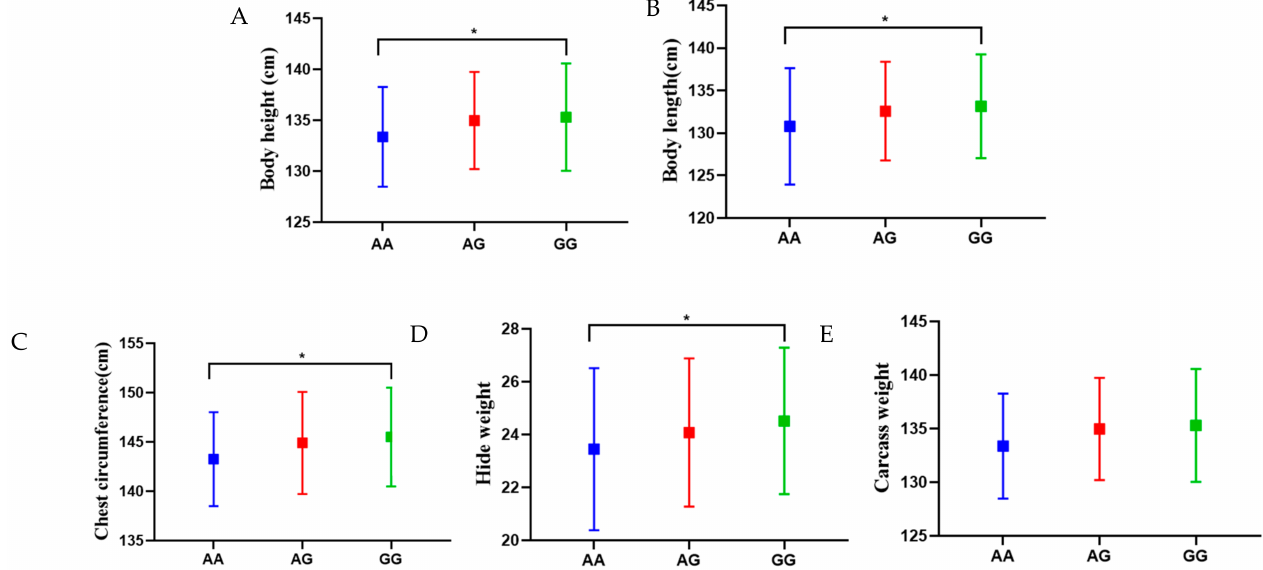
Figure 2. Effect of different genotypes at the g.112558859 A > G locus on traits. * p < 0.05. In addition to growth traits, hide weight is also an important indicator for donkey breeding. The hide weights of donkeys with these genotypes were significant different ( p < 0.05), with donkeys of the GG genotype having the highest hide weight; the hide weight of donkeys with the AA genotype was 1.07 Kg lighter (Table 2). On the contrary, Wang et al. [4] reported that the LCORL gene was not included among the genes associated with donkey hide thickness. The present study shows that the LCORL gene g.112558859 A > G locus increased the hide area by increasing the body height, body length and